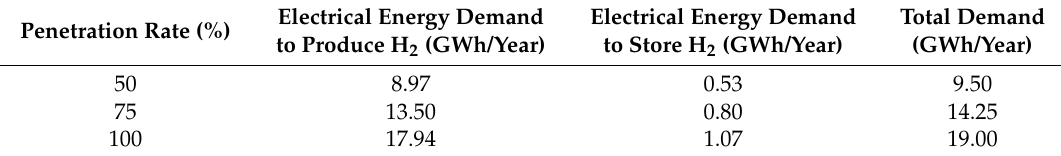
Table 3. Penetration scenarios and electrical energy